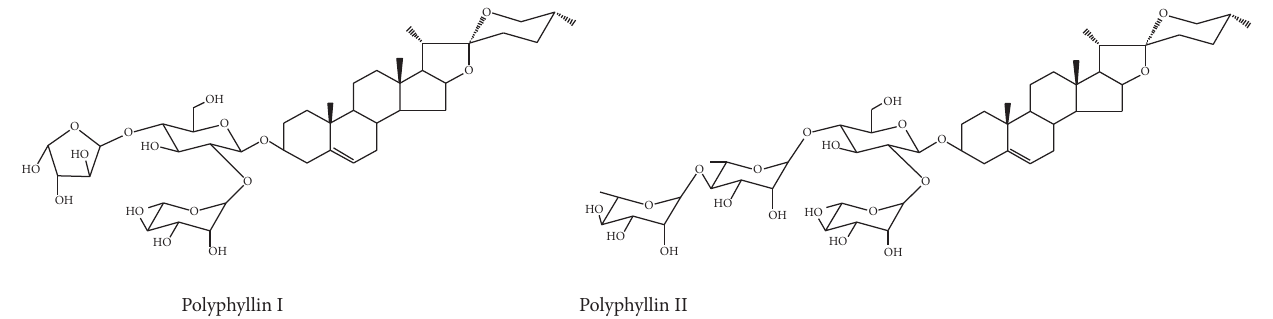
Figure 1: Structure of polyphyllin I and polyphyllin II.